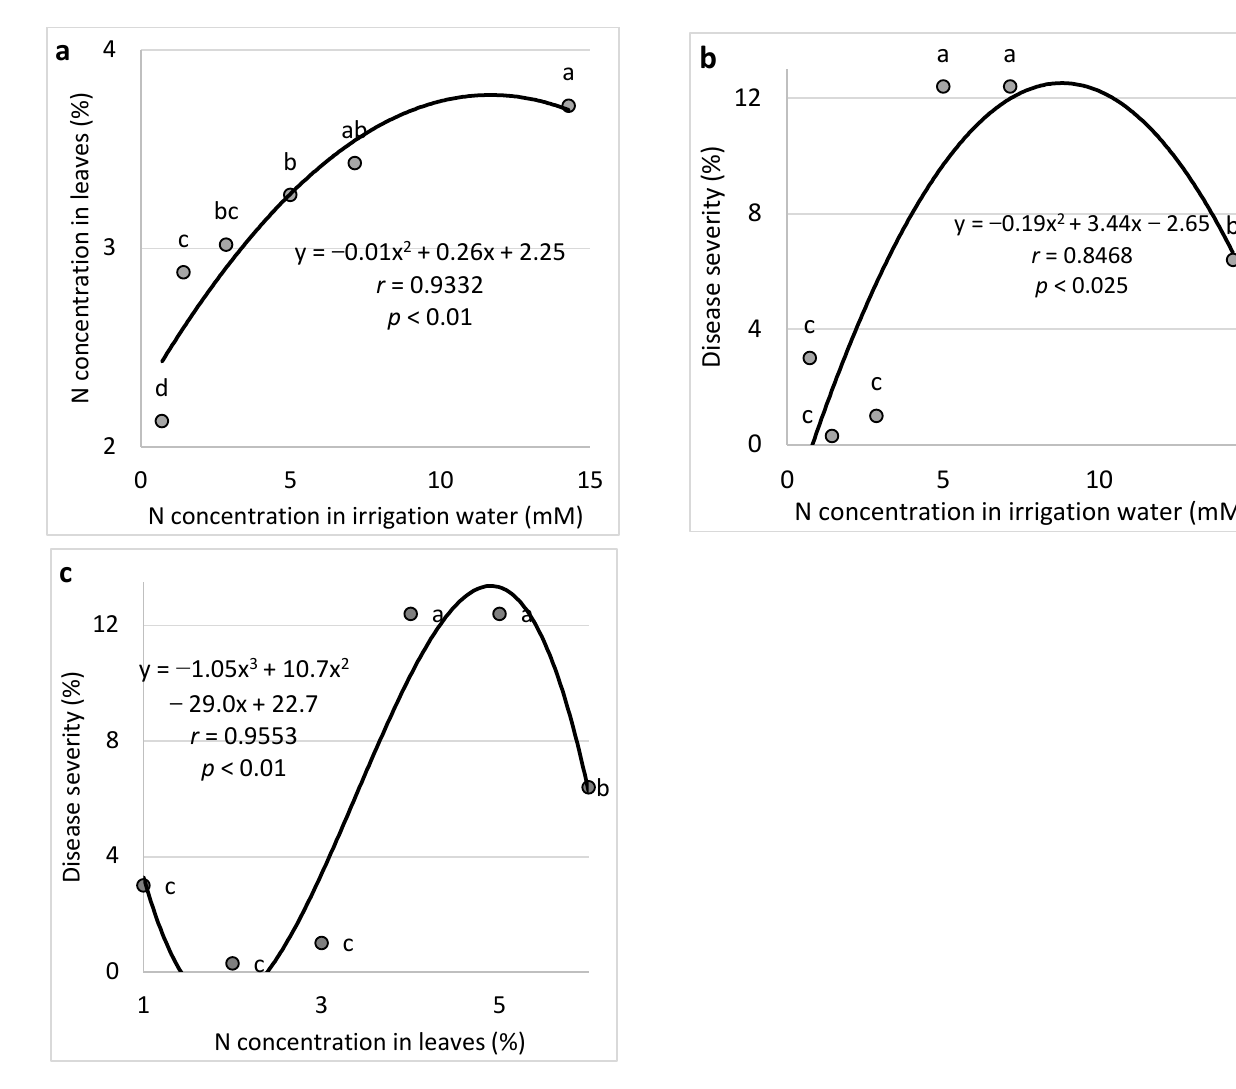
Figure 1. Effect of N concentration treatments in the irrigation water on cucumber downy mildew (CDM, Pseudoperonospora cubensis ). N concentration in the leaves is presented in relation to N concentration in the irrigation water ( a ), CDM severity is presented in relation to N concentration in the irrigation water ( b ), and CDM severity is presented in relation to the N concentration in the leaves ( c ). The disease was evaluated on a 0 to 100% severity scale, where 0% = healthy leaves and 100% = leaves completely covered by CDM symptoms. Values of the area under the disease progress curve (AUDPC) were calculated for 18 days after disease onset. In each graph, values for each N treatment followed by a common letter are significantly not different from each other according to Tukey-Kramer’s HSD test ( p ≤ 0.05). The regression formulas of the drawn trend lines are presented, and the correlation Pearson regression values ( r ) are presented along with significance levels ( p ).